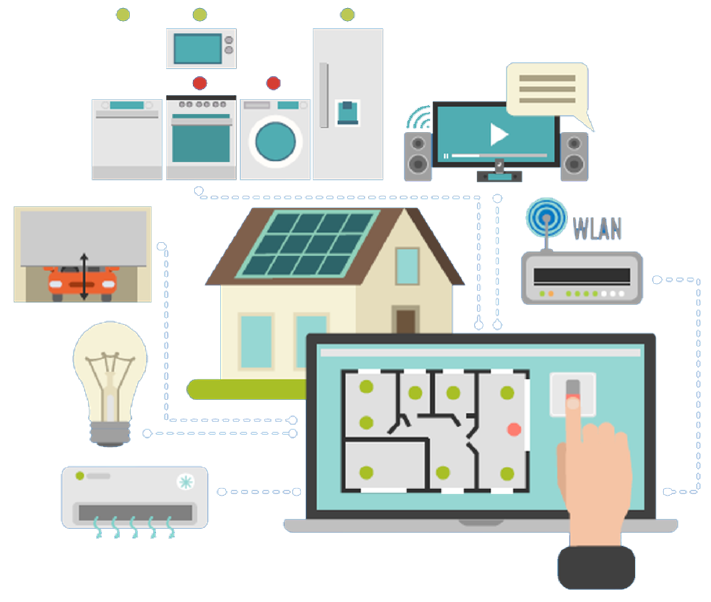
Figure 2. Connected appliance-based home